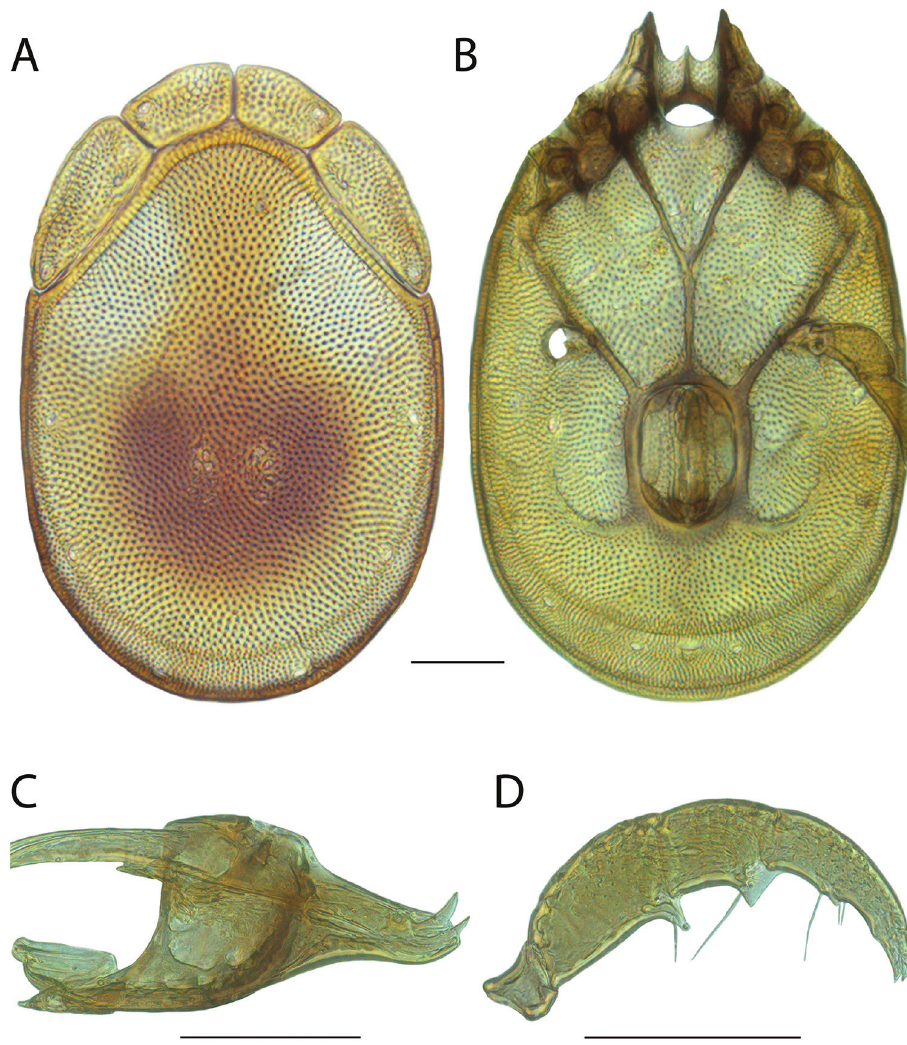
Figure 40. Torrenticola cardia sp. n. male: A dorsal plates B venter (legs removed) C subcapitulum D pedipalp (setae not accurately depicted). Scale = 100